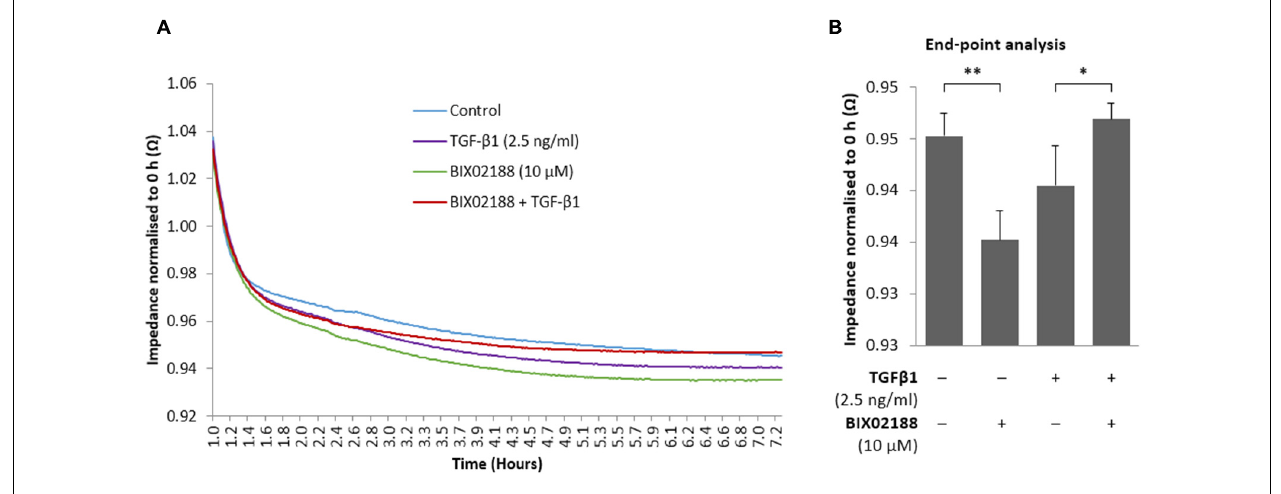
FIGURE 4 | Regulation of podocyte barrier function via Erk5. (A,B) Podocytes pre-incubated for 60 min with the Mek5 inhibitor BIX02188 (10 μ M) followed by co-incubation with TGF β 1 (2.5 ng/ml) for 6 h and subjected to ECIS where transcellular impedance was measured. TGF β 1 reduced podocyte transcellular impedance. BIX02188 treatment alone